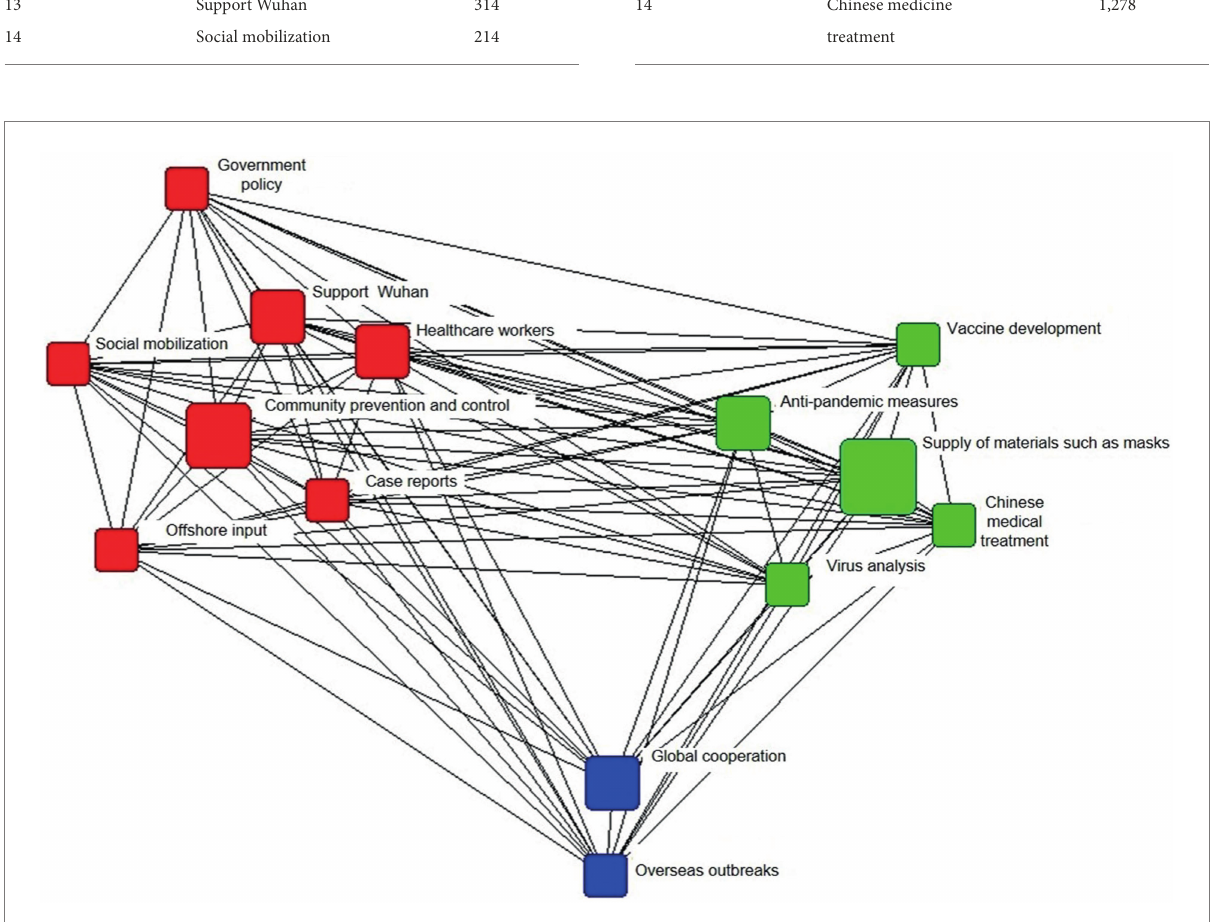
FIGURE 5 The network of the implicit public